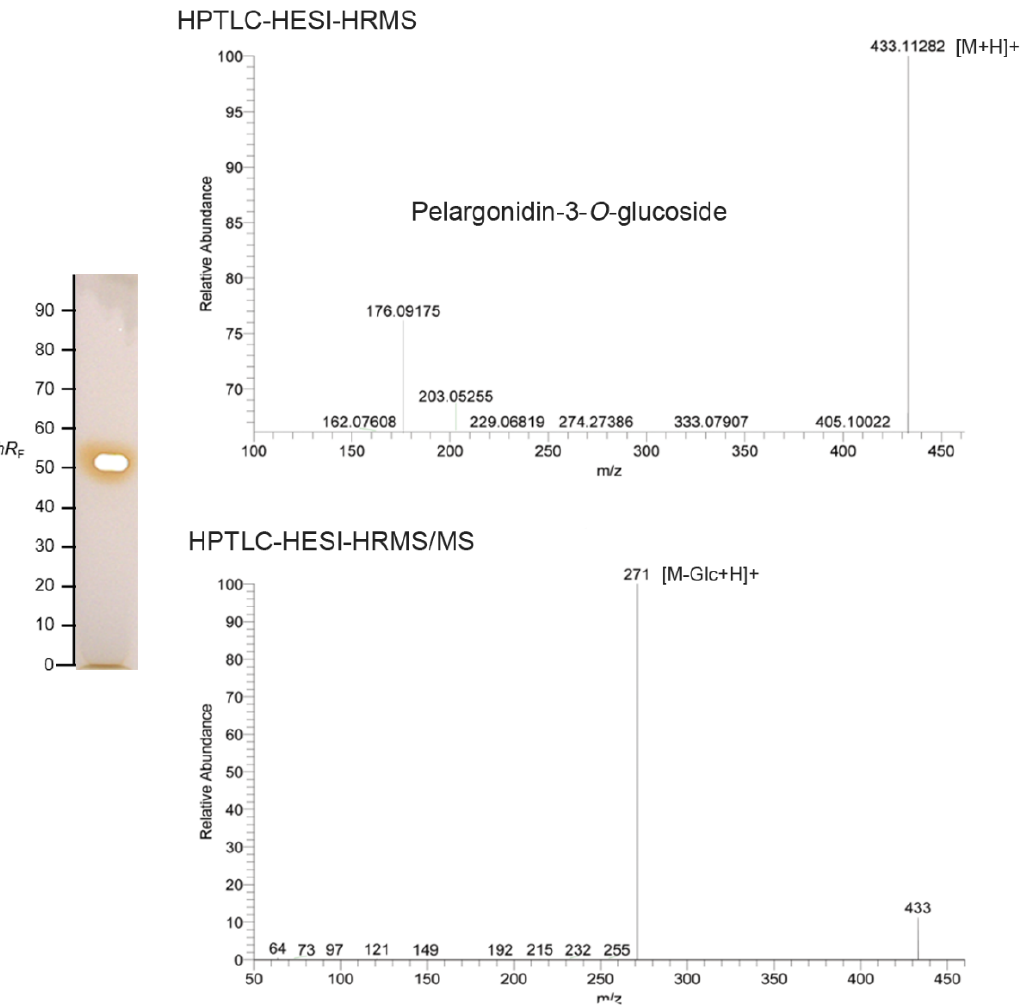
Figure 2. HPTLC ‐ HESI ‐ HRMS and fragmentation spectra of the red, UV ‐ active, antibacterial and antioxidative zone at hR F 50 (image after zone elution), assigned as pelargonidin ‐ 3 ‐ O ‐ glucoside.